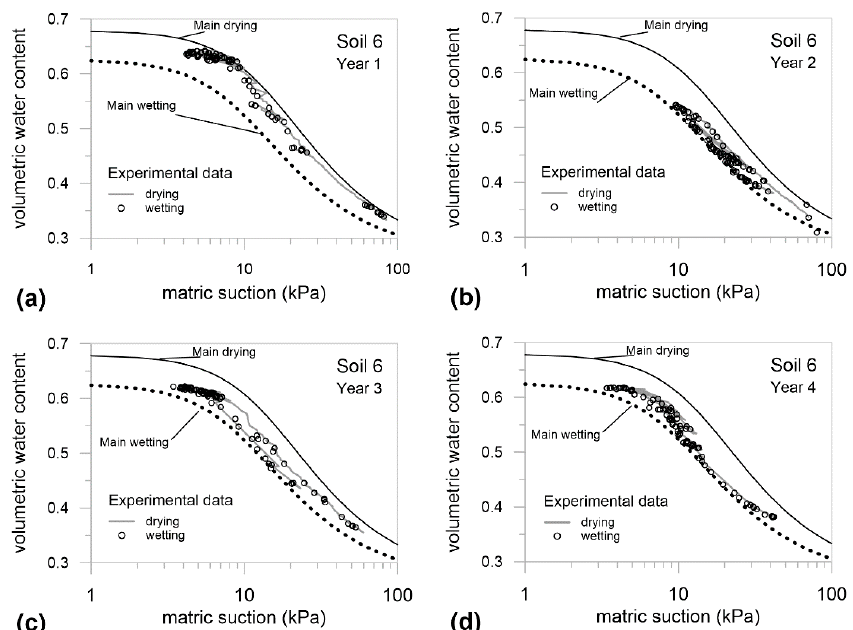
Figure 7. Results for soil 6 through monitoring by the lysimeter (medium scale). The main loop obtained from the inverse analysis of the first hydrological year (main drying and main wetting) overlaps with the experimental data recorded during the physical model monitoring over the ( a ) first, ( b ) second, ( c ) third, and( d ) fourth hydrological year.